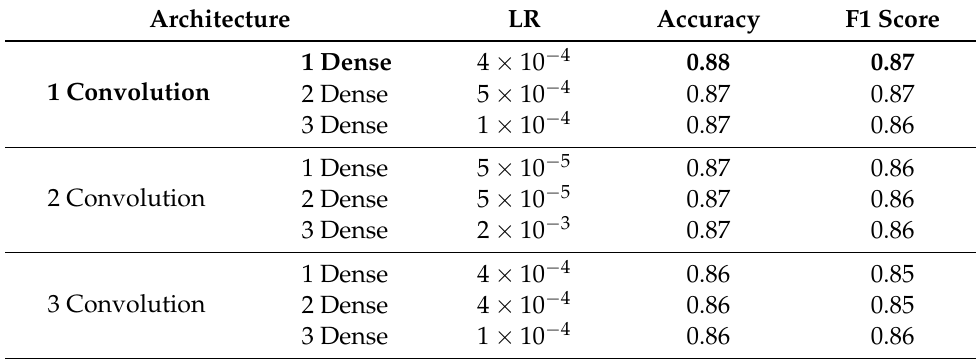
Table 9. Comparing CNN-based classifier results using the BERT